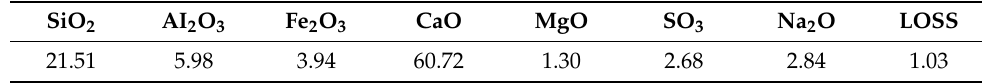
Table 2. Chemical composition of cement (%).